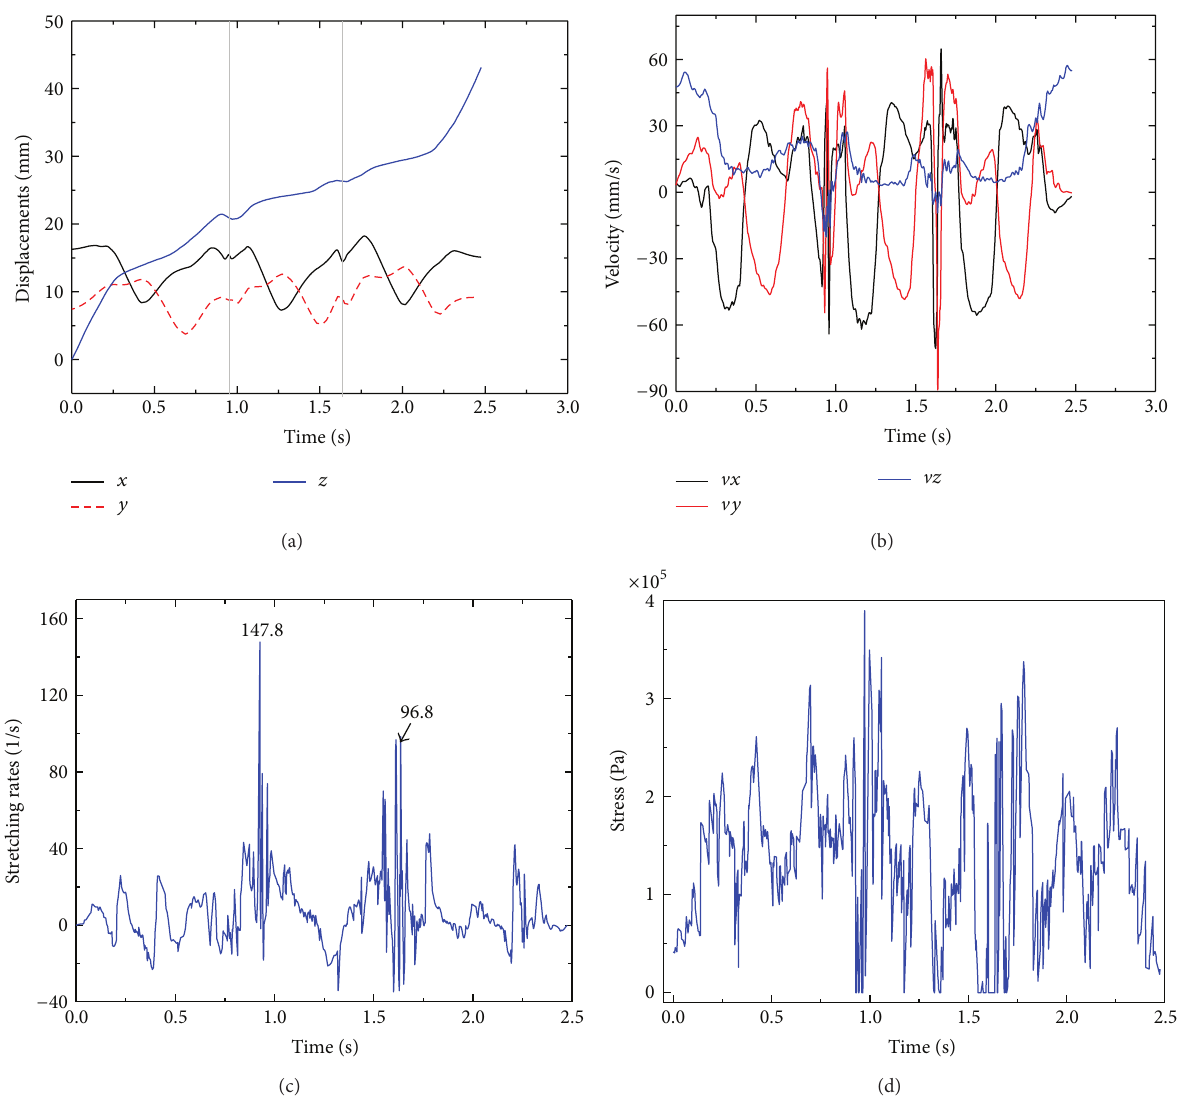
Figure 5: Periodical behaviors of Particle 3 in the tri-screw extruder: (a) displacement; (b) velocity; (c) stretching rate; (d) stress.